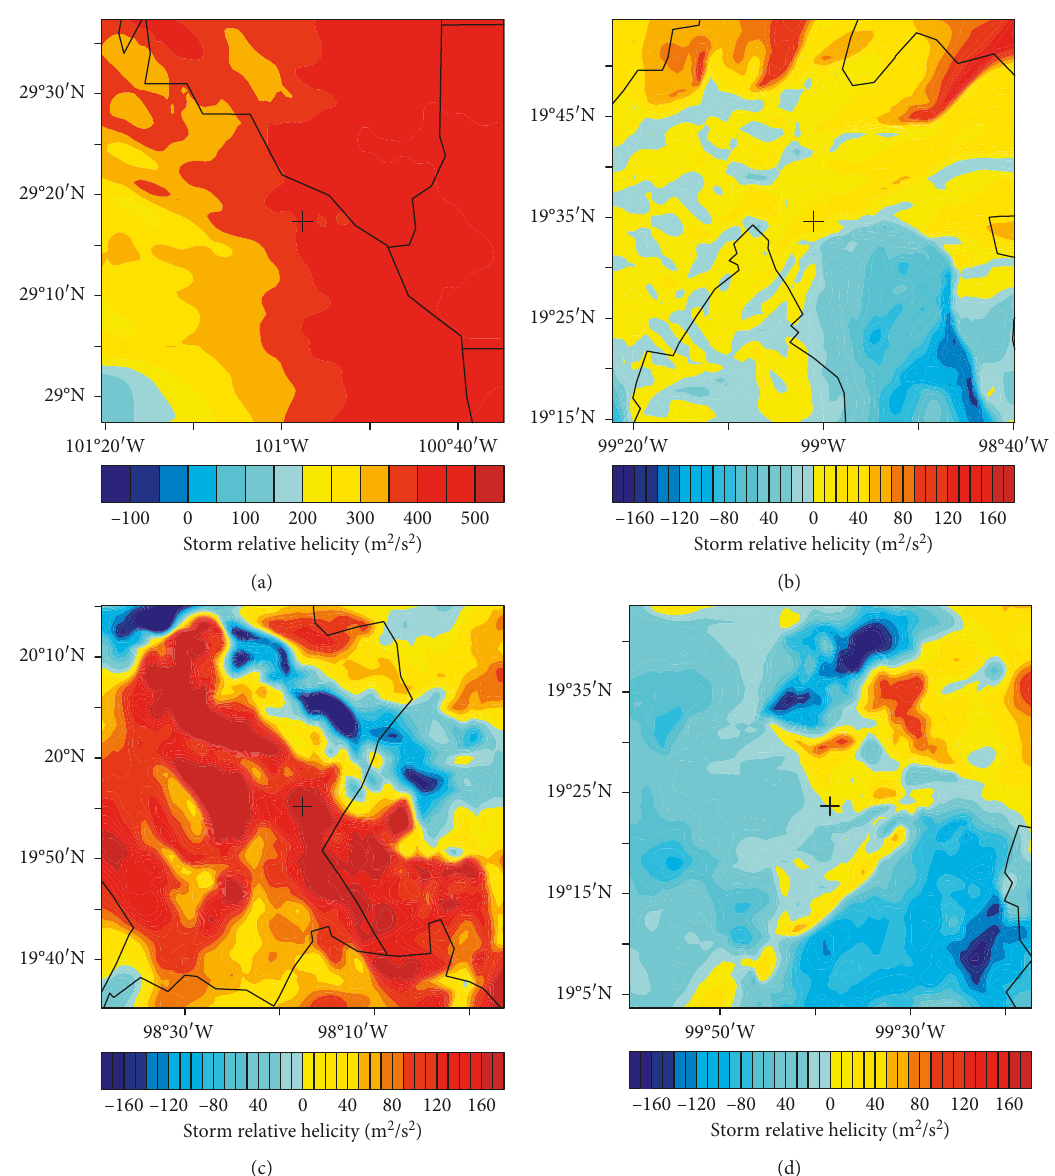
Figure 7: Storm relative helicity integrated between 0 and 1km for cyclonic tornadoes in domain D3. Tornado formed in a supercell system in Ciudad Acuña (a), I.D. 15 (b), I.D. 20 (c), and I.D. 24 (d) (Table 1 for I.D. numbers). The black crosses indicate the position of the